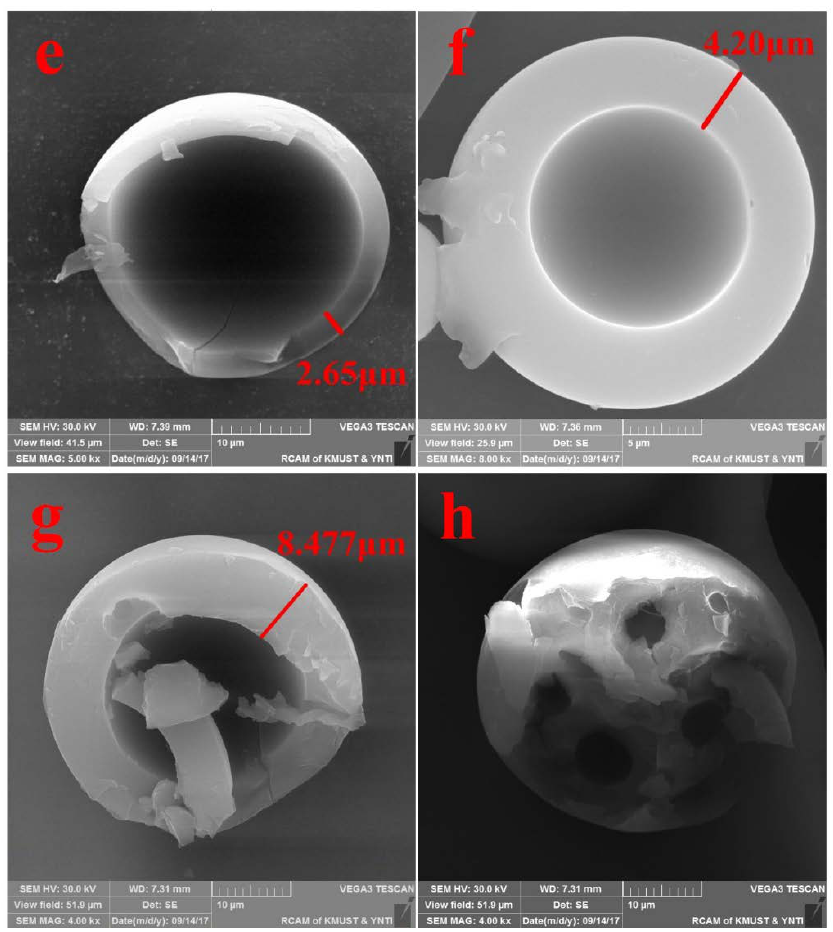
Figure 4. SEM images of PS microspheres prepared under varying experimental conditions: ( a – d ) water is used as a continuous phase and PS/DCM is 5 wt %, 10 wt %, 16.7 wt %, 25 wt %, respectively; ( e – h ) 10.0 wt % EtOH solution is used as a continuous phase and PS/DCM is 5 wt %, 10 wt %, 16.7 wt %, 25 wt %, respectively.